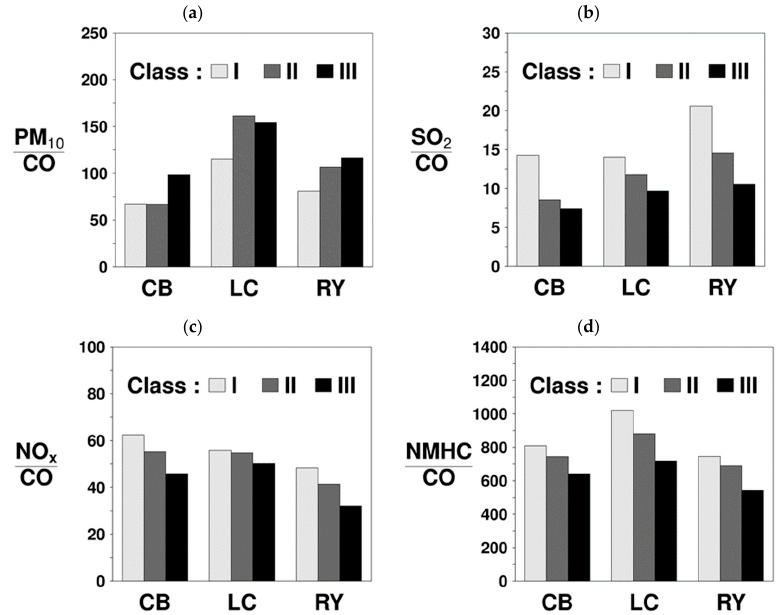
Figure 8. ( a ) PM 10 /CO ( µ g m − 3 ppm − 1 ); ( b ) SO 2 /CO (ppb ppm − 1 ); ( c ) NO x /CO (ppb ppm − 1 ); and ( d ) NMHC/CO (ppbc ppm − 1 ) by visibility class at stations CB, LC, and RY.